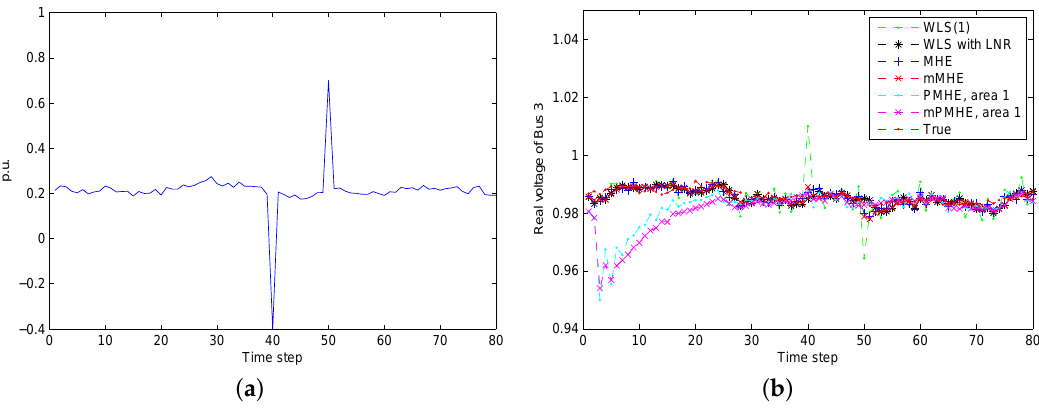
Figure 5. ( a ):The raw current measurement I r and 50. ( b ) The estimated result ˆ V r results when the WLS estimator uses the measurements with horizon length